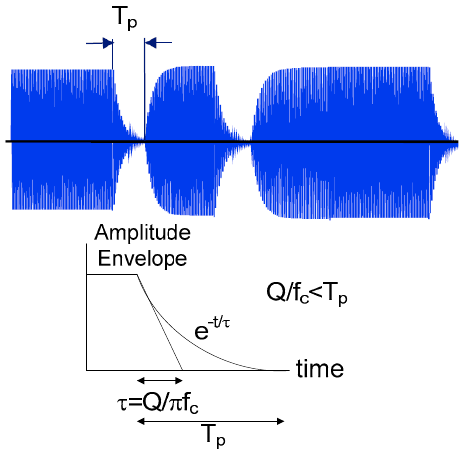
Figure 4. Typical time-domain modulated waveform ( top ) and idealized response of a second-order system with quality factor Q ( bottom ). The transitory response duration is of the order f c / Q < T p .